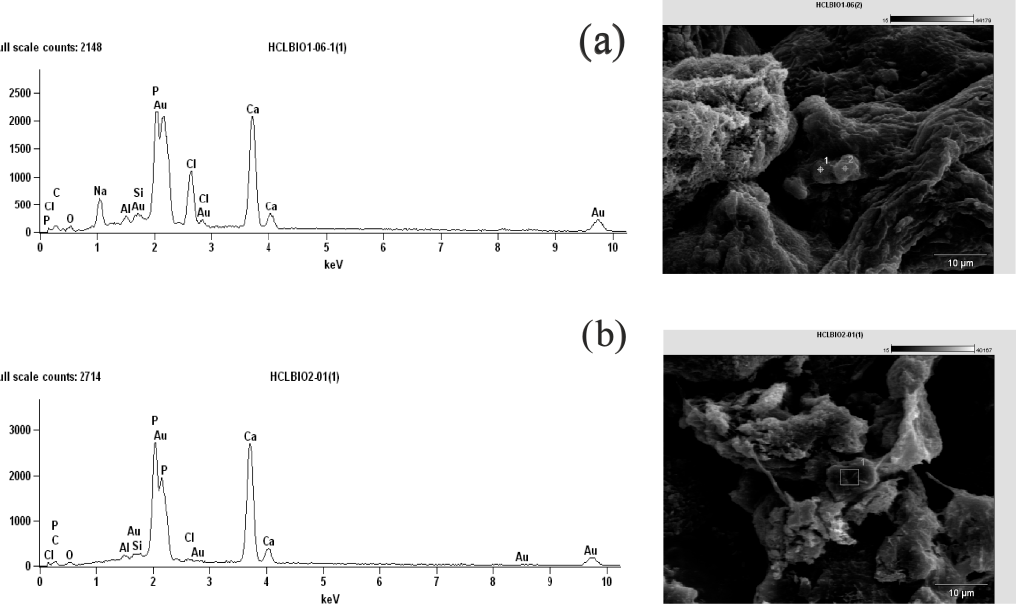
Figure 9. EDX analysis (left panel) and SEM images (right panel) obtained after 7 days of the biomineralization process for: ( a ) the hydrogel H1-EDC/CaCl 2 ; ( b ) the hydrogel H2-CaCl 2 /EDC.